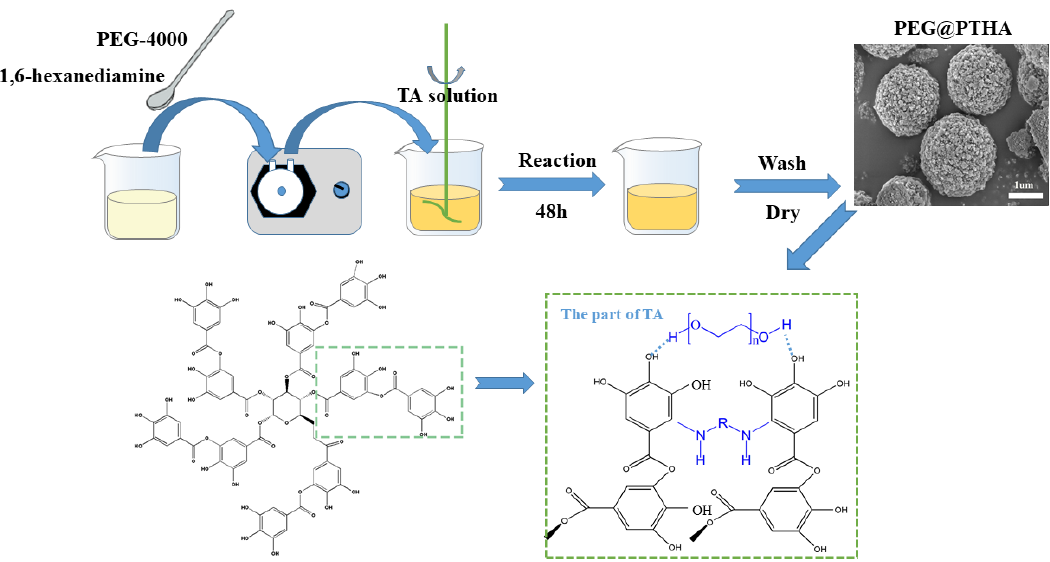
Figure 1. Schematic diagram of preparation procedure and possible preparation mechanism of the PEG@PTHA composite adsorbent.